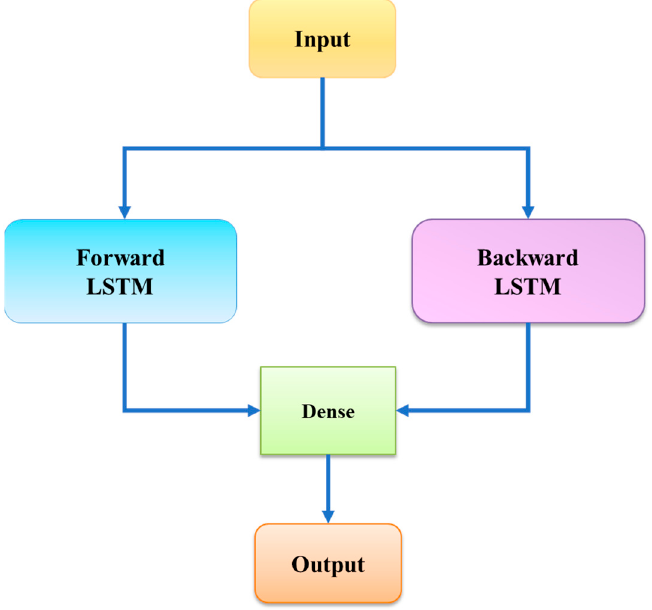
Figure 3. BLSTM flowchart.